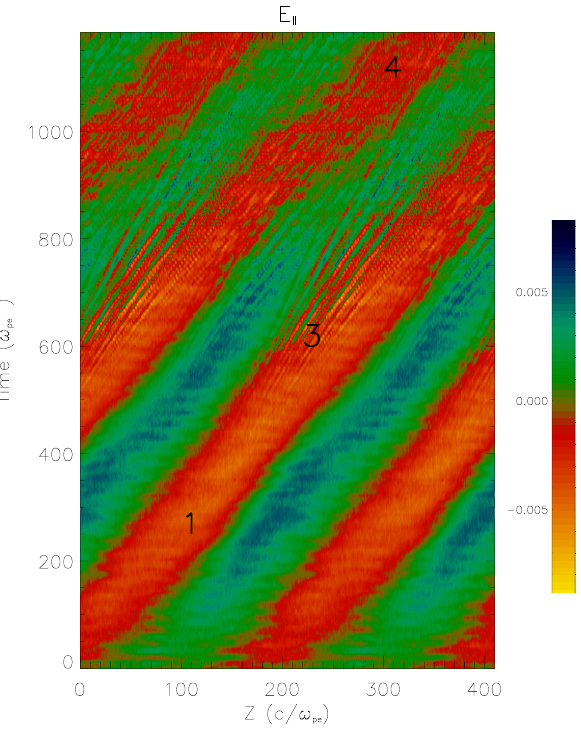
Fig. 3. Similar to Fig. 2 for the low amplitude case δB/B = 0 . 025. The Buneman instability (label 2 in Fig. 2) is not